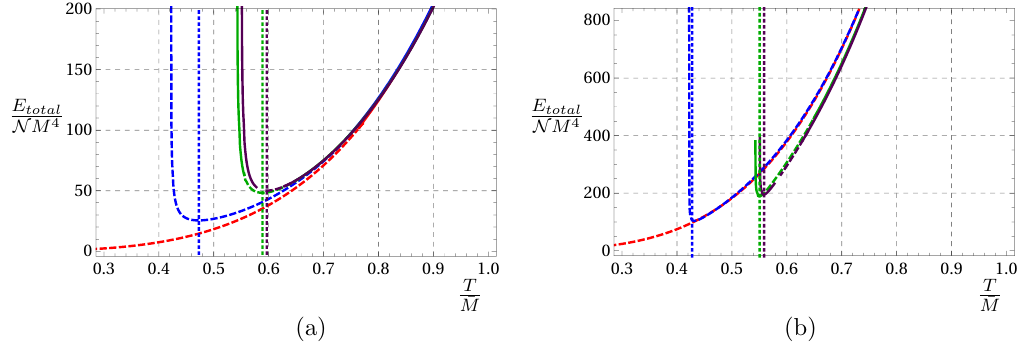
Figure 13 . Total energy density E total = N (cid:22) M 4 of the color and (cid:13)avor degrees of freedom as a function of T= (cid:22) M . Red, blue, green, and purple curves (bottom to top) correspond to b= (cid:22) M 2 = f 0 ; 2 ; 3 : 3 ; 3 : 4 g respectively. The dashed segments correspond to Minkowski embeddings, while the continuous segments correspond to black hole embeddings. The dotted vertical lines denote the temperature at which the speci(cid:12)c heat becomes negative for each magnetic (cid:12)eld other than zero ( b= (cid:22) M 2 = f 2 ; 3 : 3 ; 3 : 4 g from left to right). (a) corresponds to N c =N f = 100 while (b) corresponds